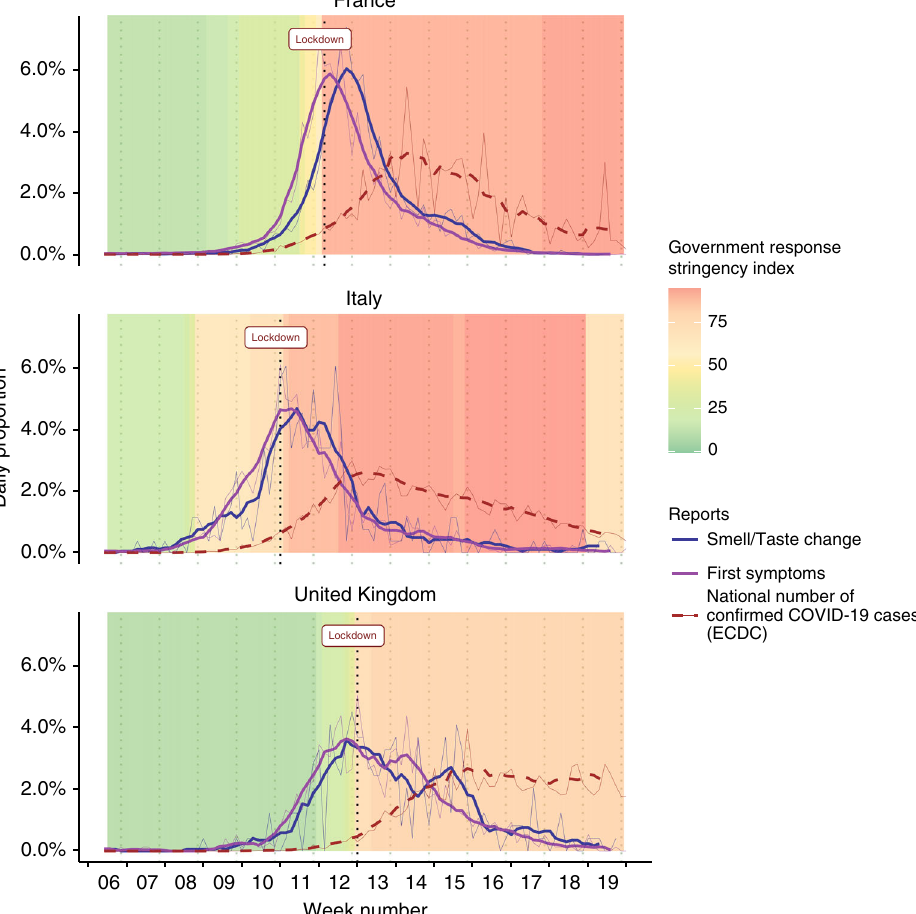
Fig. 2 Evolution of COVID-19 indicators before and after the lockdown in France, Italy and the UK. The daily proportion of fi rst symptoms is shown as a violet line (France, n = 4720, Italy, n = 1241, UK, n = 750). The daily proportion of smell/taste changes is shown as a blue line (France, n = 1487, Italy, n = 264, UK, n = 263). The daily proportion of COVID-19 con fi rmed cases from the European Centre for Disease Prevention and Control (ECDC) is shown as a red dashed line. Each panel shows both raw data (thin line) and the corresponding 7-day running average (thick line). The government response stringency index is shown as the background